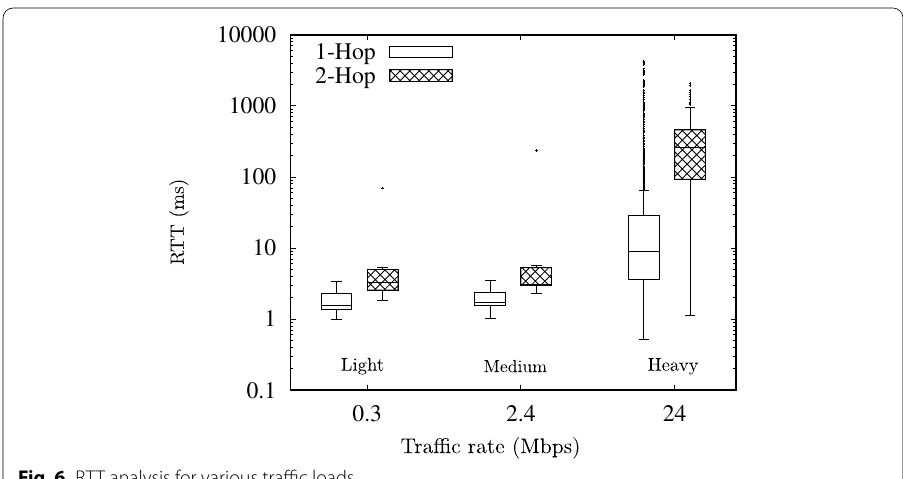
Fig. 6 RTT analysis for various traffic